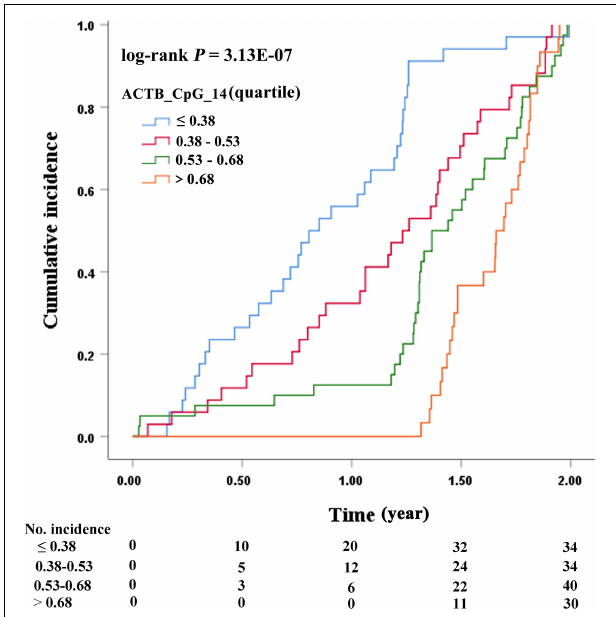
FIGURE 3 | Association between ACTB_CpG_14 methylation and cumulative incidence of stroke by cumulative incidence